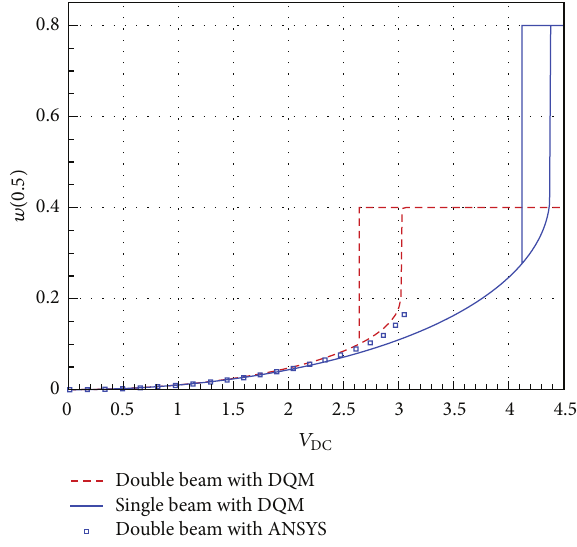
Figure 2: Microbeams deflection under an applied DC voltage and validation with ANSYS